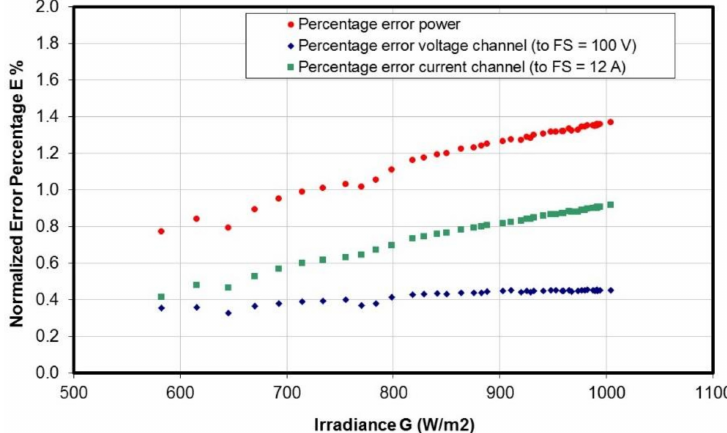
Figure 11. Variation of the percentage error of the power, the voltage channel and the current channel for the polycrystalline silicon PV